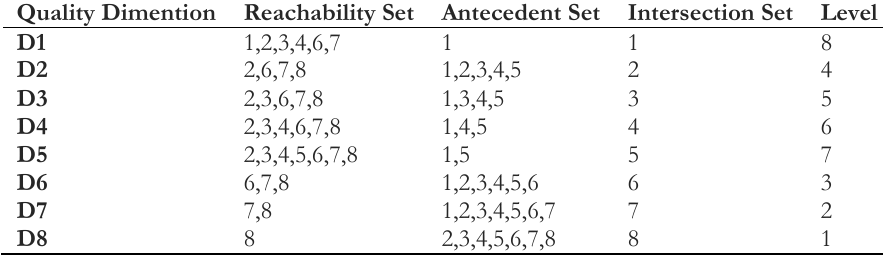
Table 3. Levels of RL AIRQUAL quality dimensions based on adapted primary acquisition matrix.